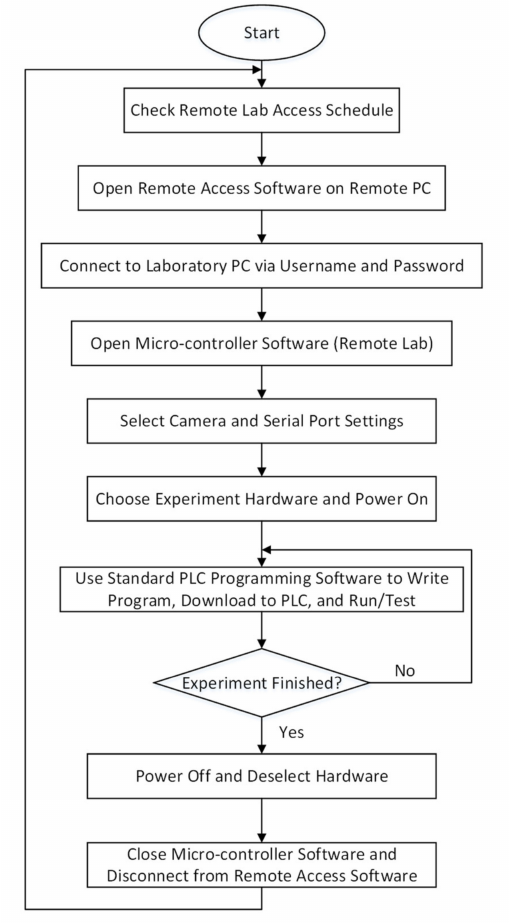
Figure 5. Simplified flowchart of the remote laboratory operating